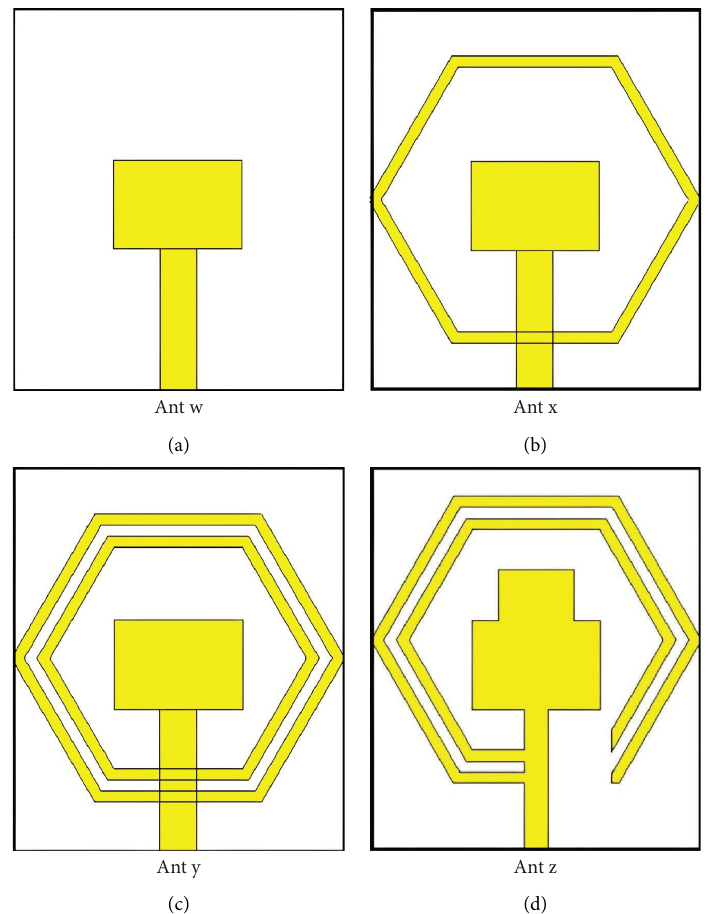
Figure 1: Evolution of the proposed low-SAR penta-band microstrip patch antenna. (a) Ant w. (b) Ant x. (c) Ant y. (d) Ant z.